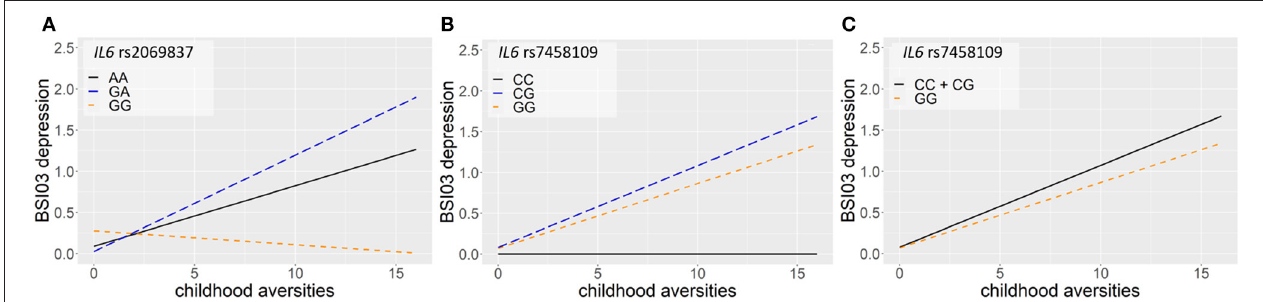
FIGURE 3 | Linear regression models on the interaction between IL6 and childhood adversities on current suicidal ideation (SI-BSI03) yielded three significant clumps, consisting of one SNP each. In the additive model, one identified clump contained rs2069837 with the minor allele G as a risk allele ( p = 0.0006) (A) . Furthermore, one clump containing also one SNP, rs7458109, was significant in both additive and dominant models, with the minor C as a risk allele ( p = 0.0006 and p = 0.0004 for additive and dominant models, respectively) (B,C) . The figure was generated for illustration purposes using